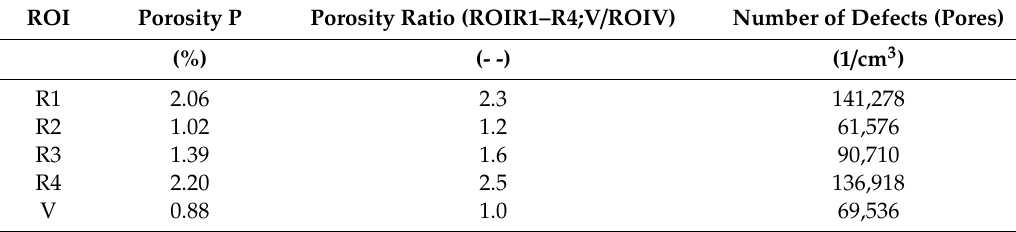
Figure 25. Pore distribution in the z direction (XY plane). Table 6. The values of porosity for sample 5 SLM in individual regions of